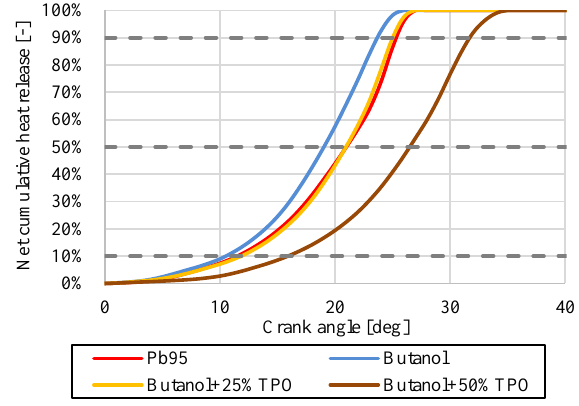
Fig. 7. Net cumulative heat release for various fuel